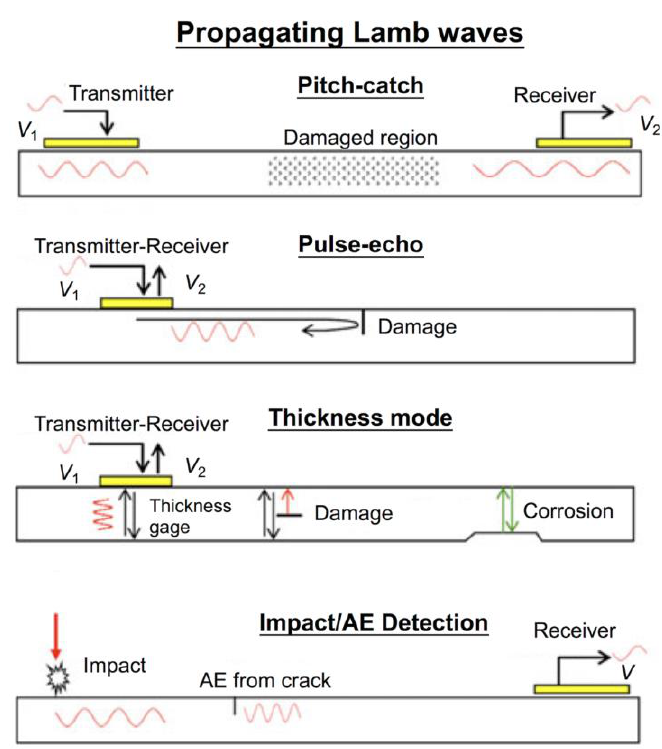
Figure 7. Modes of operation of piezoelectric transducers using propagating Lamb waves [79].